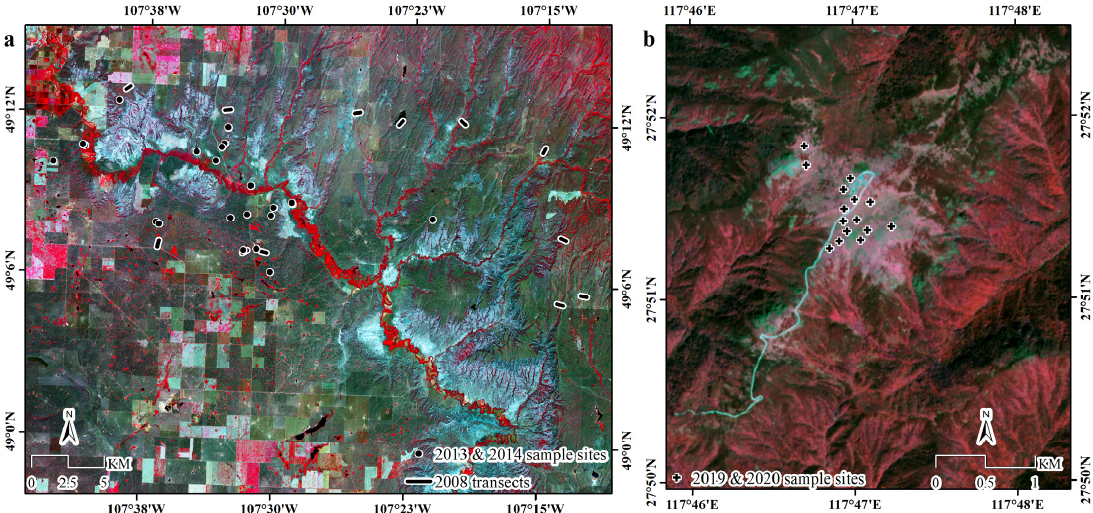
Figure 1. Study area: ( a ) Grasslands National Park (GNP) and the surrounding pastures (the back- ground image is a Sentinel-2 scene acquired on 17 July 2017, with a standard false color composition (near-infrared, red and green band in red, green, and blue channel, respectively)); ( b ) subalpine meadow in Wuyishan National Park (the background image is a Sentinel-2 scene acquired on 19 September 2019, with a standard false color composition). Table 1. Description of the field collected in both Grasslands National Park (GNP) and Wuyishan National Park